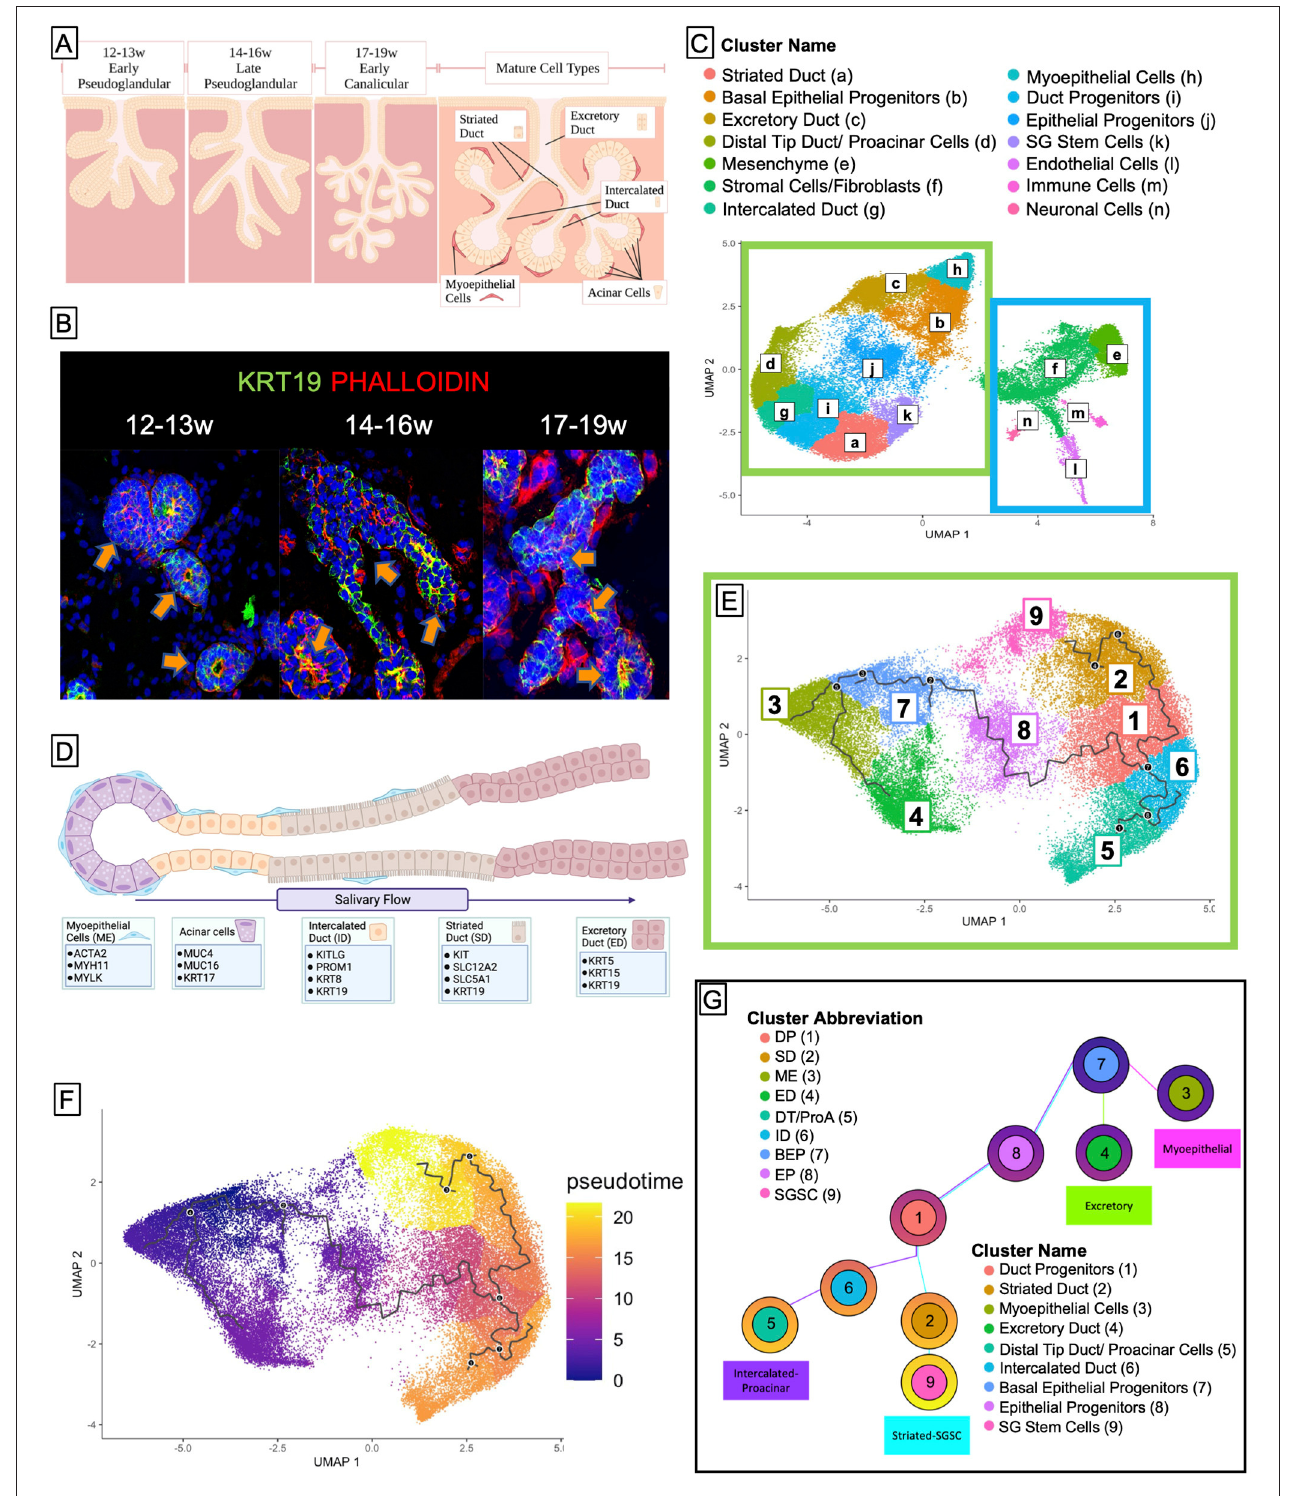
FIGURE 1 | Cell clustering and pseudotime analysis reveal four distinct developmental trajectories for major tissues in the salivary gland. (A) Salivary gland development begins in humans at 6 weeks gestation and goes through several stages, the latter of which are the pseudoglandular stage and the canalicular